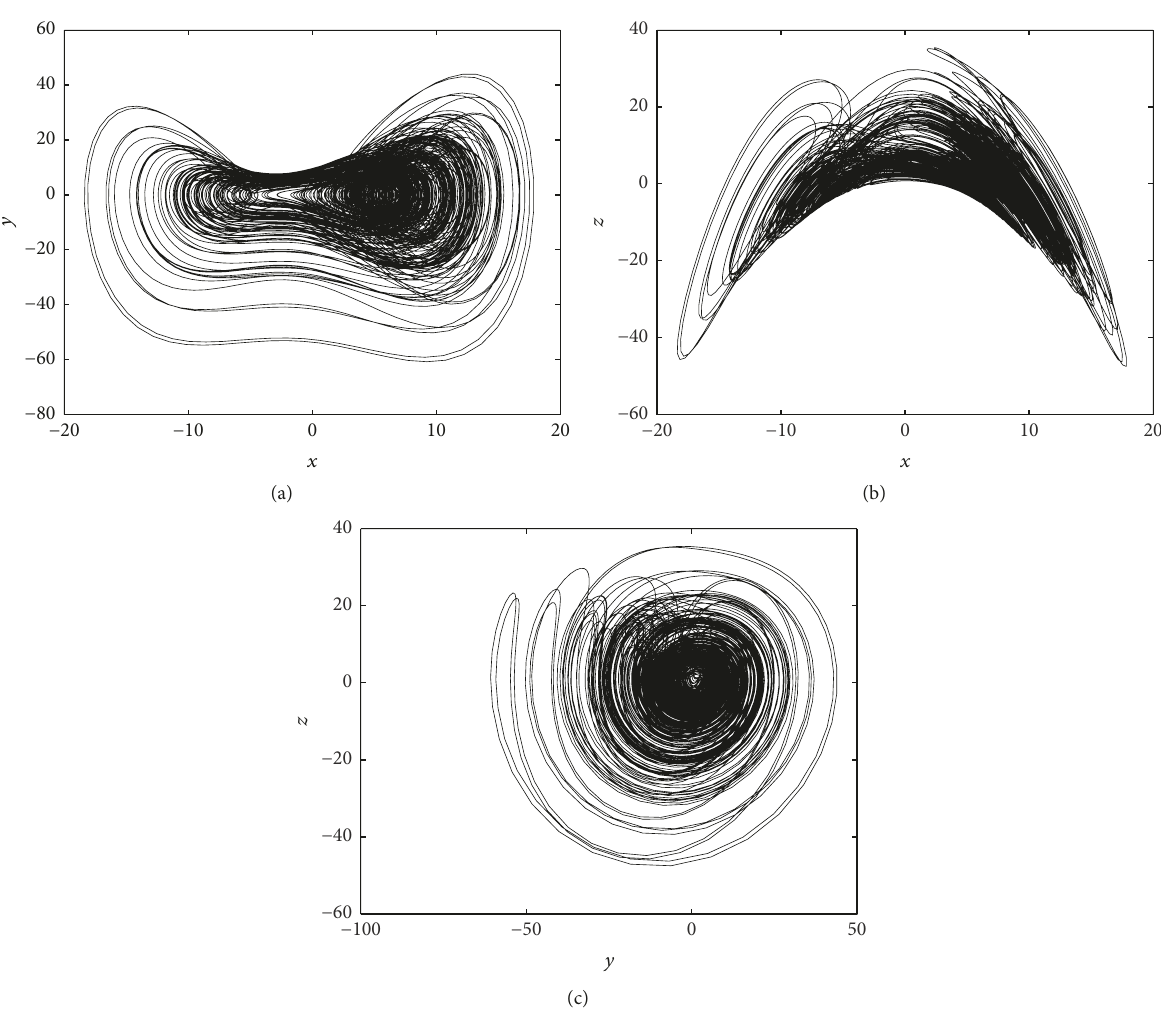
Figure 1: Projections of attractors without equilibrium in (a) 𝑥 − 𝑦 plane, (b) 𝑥 − 𝑧 plane, and (c) 𝑦 − 𝑧 plane for 𝑎 = 2 , 𝑏 = 0.1 , 𝑐 = 2.5 , and 𝑑 = 0.3 and initial conditions (𝑥(0),𝑦(0),𝑧(0)) = (1,1, 1) . The attractor of system (8) is “hidden” according to the definition introduced in